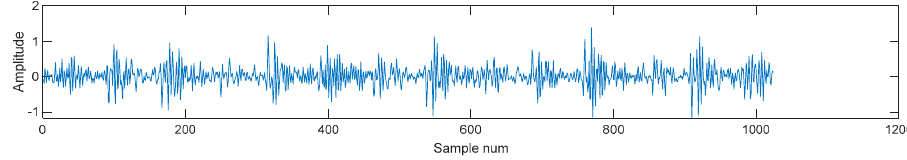
Figure 7. The intercepted signal.